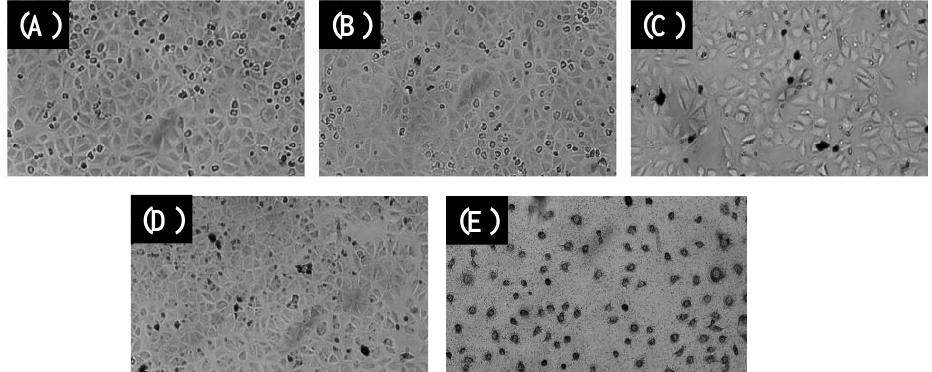
Figure 9. MCF-7 cell lines cellular image representation in DMEM without nanocomposites ( A ); after incubation with MRGO ( 312.5 μg/mL) ( B ); Chi@MRGO ( 5000 μg/mL) ( C ); PF127-Chi@MRGO ( 1250 μg/mL) ( D ); α -mangosteen-loaded PF127-Chi@MRGO ( 5000 μg/mL) ( E ).